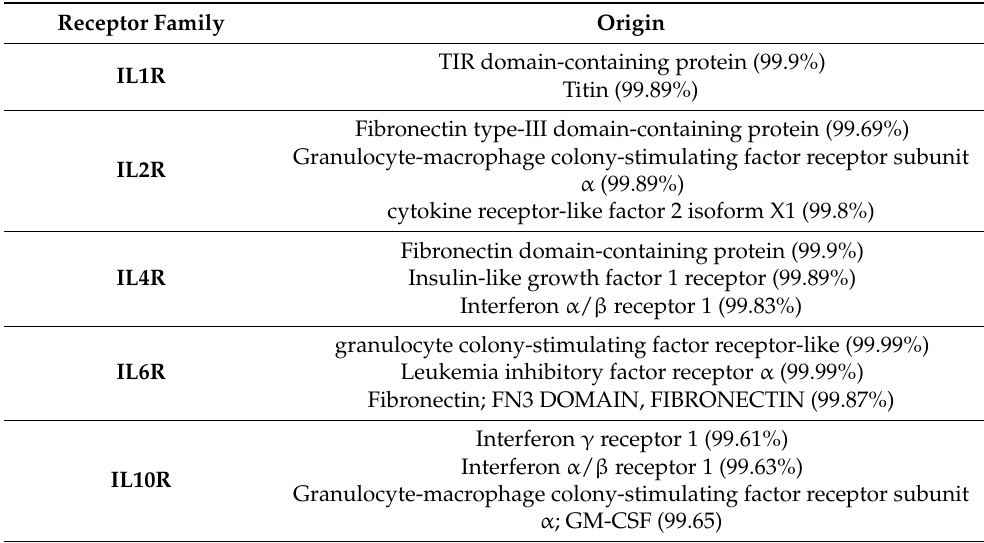
Table 1. Estimated origins of the IL families and their